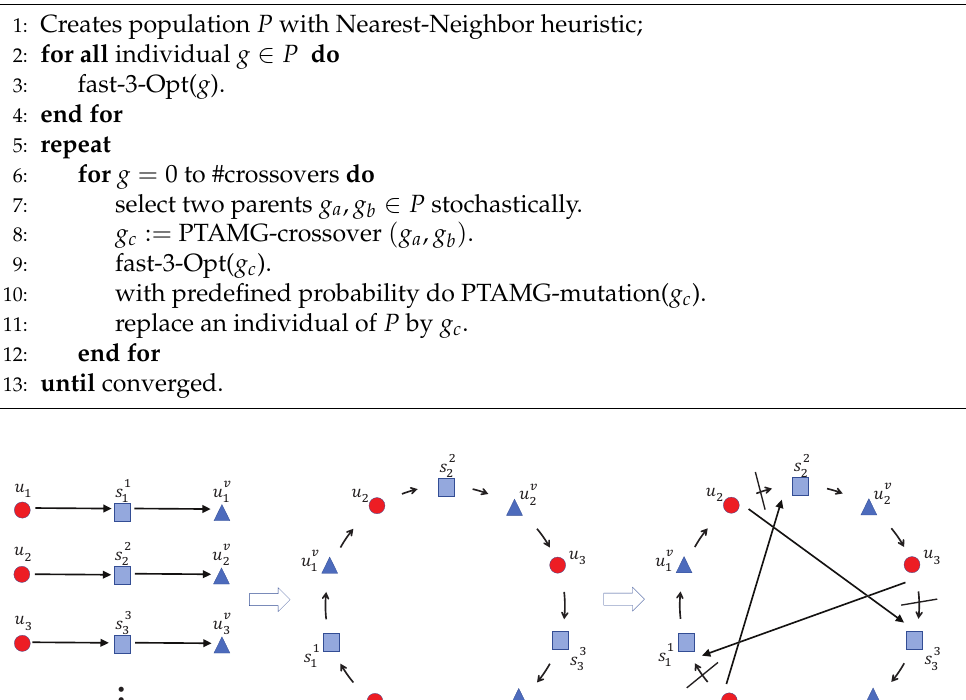
Algorithm 4 PTAM-Genetic Algorithm.